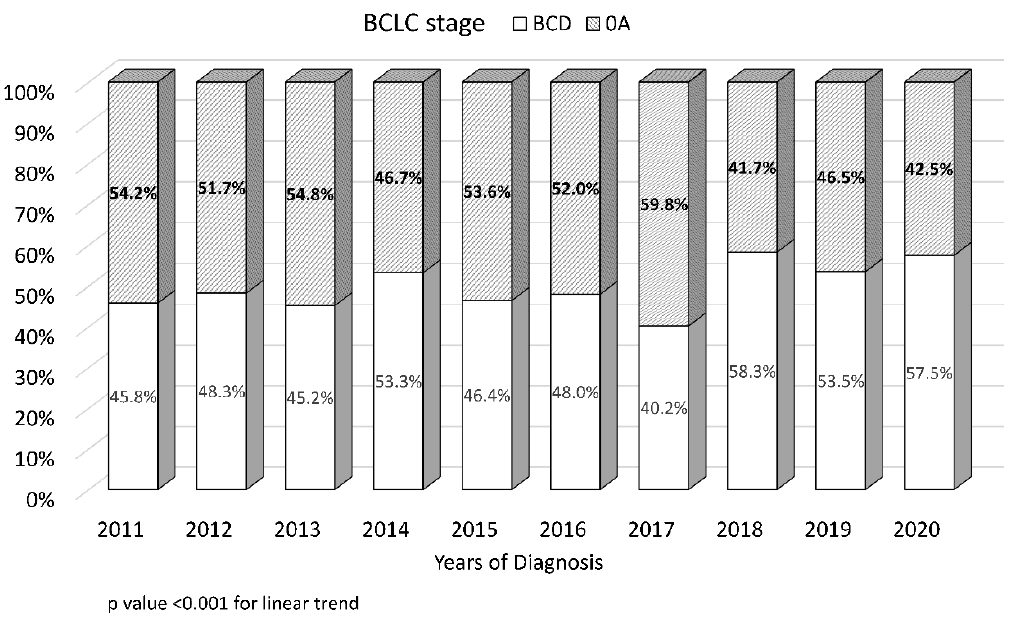
Figure 2. Trend in early-stage tumor at the time of hepatocellular carcinoma diagnosis. Early-stage tumor was defined as Barcelona Clinic Liver Cancer classification stages 0–A.